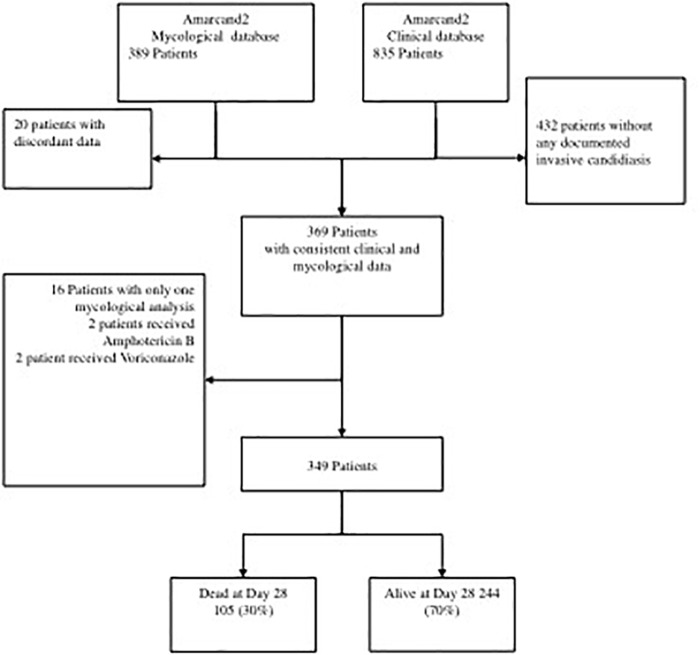
Study flowchart.